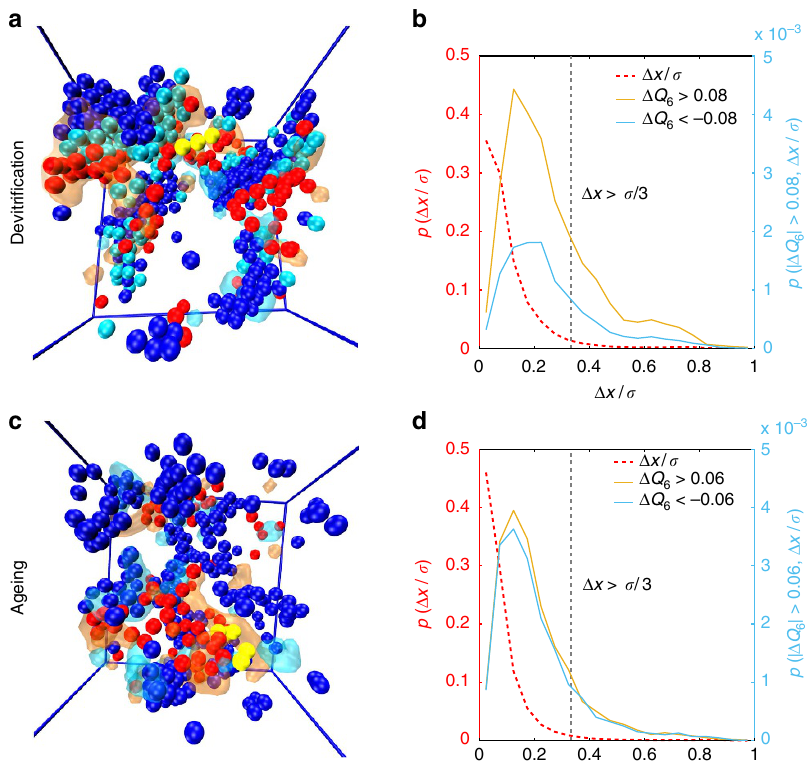
Figure 5 | Displacement and structural change. ( a ) Spatial distribution of crystalline (blue), newly crystalline (light blue), AIs (yellow) and APs (red) during an avalanche event in the monodisperse case at f ¼ 0.65. Regions which have experienced a large change in BOO, D Q 6 4 0.08 and D Q 6 o (cid:2) 0.08, are marked with a transparent orange and cyan region, respectively. ( b ) Fraction of particles with displacement D x / s for particles experiencing a large change in BOO parameter Q 6 during avalanches for monodisperse and polydisperse cases respectively. The red dashed curve is for all particles (left axis), whereas the orange and cyan curves are for particles experiencing a large positive and negative change in Q 6 respectively (right axis). The threshold is the same as in a . ( c ) The spatial distribution of MRCO regions (blue), AIs (yellow) and APs (red) during an avalanche event in the polydisperse case at f ¼ 0.65. Regions which have experienced a large change in BOO, D Q 6 4 0.06 and D Q 6 o (cid:2) 0.06, are marked as a transparent orange and cyan region, respectively. ( d ) Same as b for the ageing case. The threshold is the same as in c . Note that the peaks in both b , d occur at displacements smaller than the avalanche threshold, D x 4 s /3, for particles experiencing a large change in Q 6